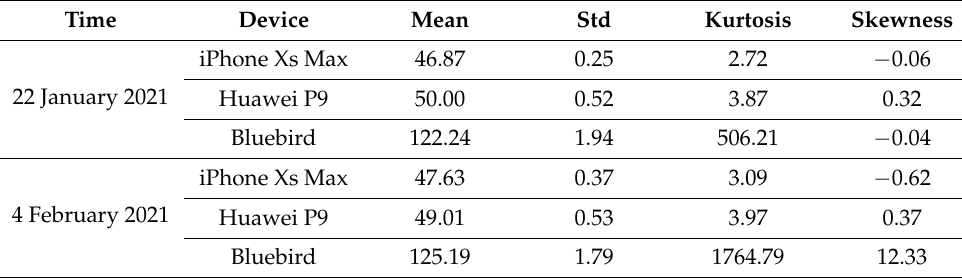
Figure 2. MF measurement of heterogeneous smartphones: ( a , c , e ) are the MFs of iPhone Xs Max, Huawei P9, and Bluebird, respectively. ( b , d , f ) are the histogram of magnitude for iPhone Xs Max, Huawei P9, and Bluebird, respectively. Table 3. Summary of MF intensity statistic